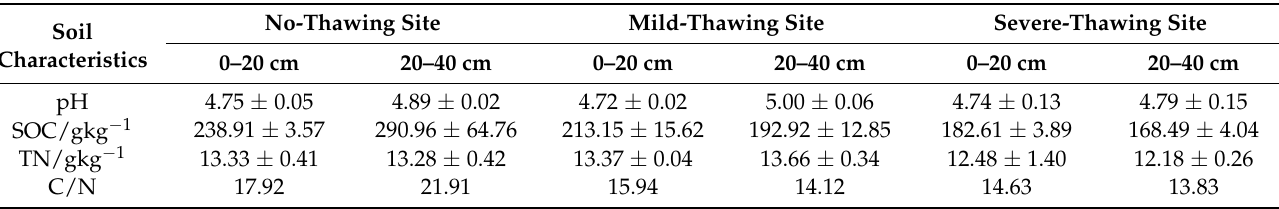
Table 1. Soil chemical characteristics in the sampling